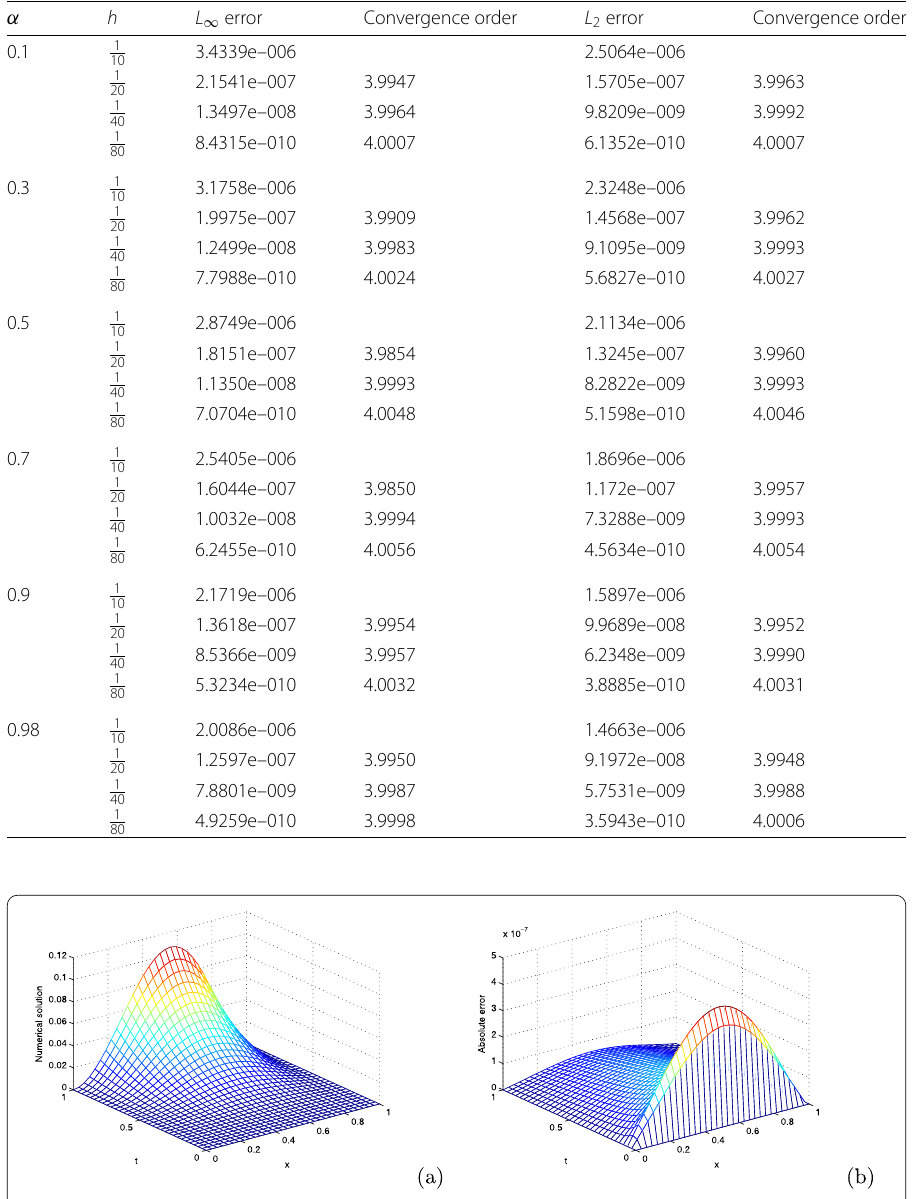
Table 2 The L ∞ , L 2 errors and spatial convergence orders with τ = 1/1000 for Example 1 α h L ∞ error Convergence order L 2 error Convergence order